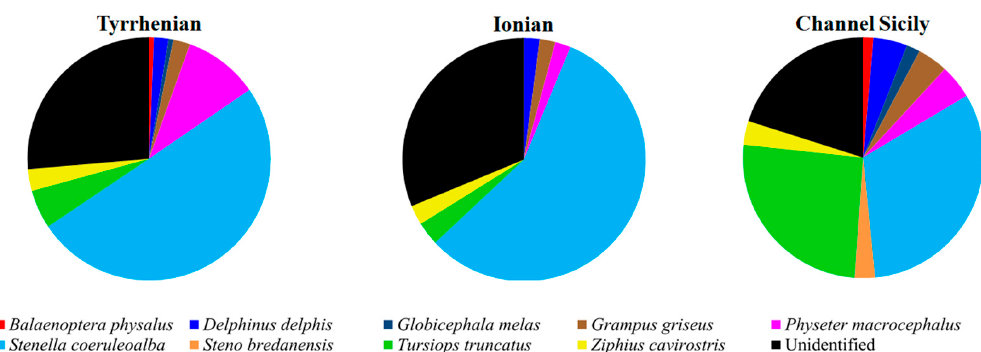
Figure 5. Percentage of carcasses of all stranded species during the period 1990–2019 (see Table 2) per each Sicilian coastal sub-area (Tyrrhenian, Ionian, and Channel of Sicily), unidentified specimens included, unique specimens excluded.